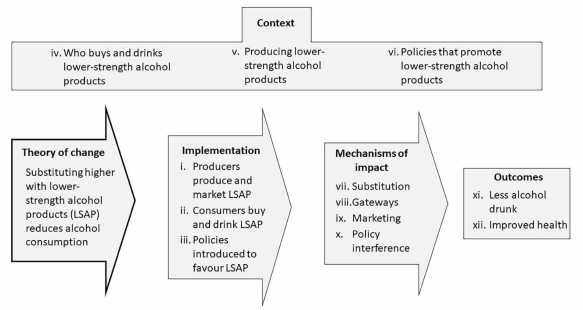
Figure 1. Logic model in which the review examines questions related to implementation, uptake of lower strength alcohol products that takes place at the levels of (i) producers, (ii) consumers,